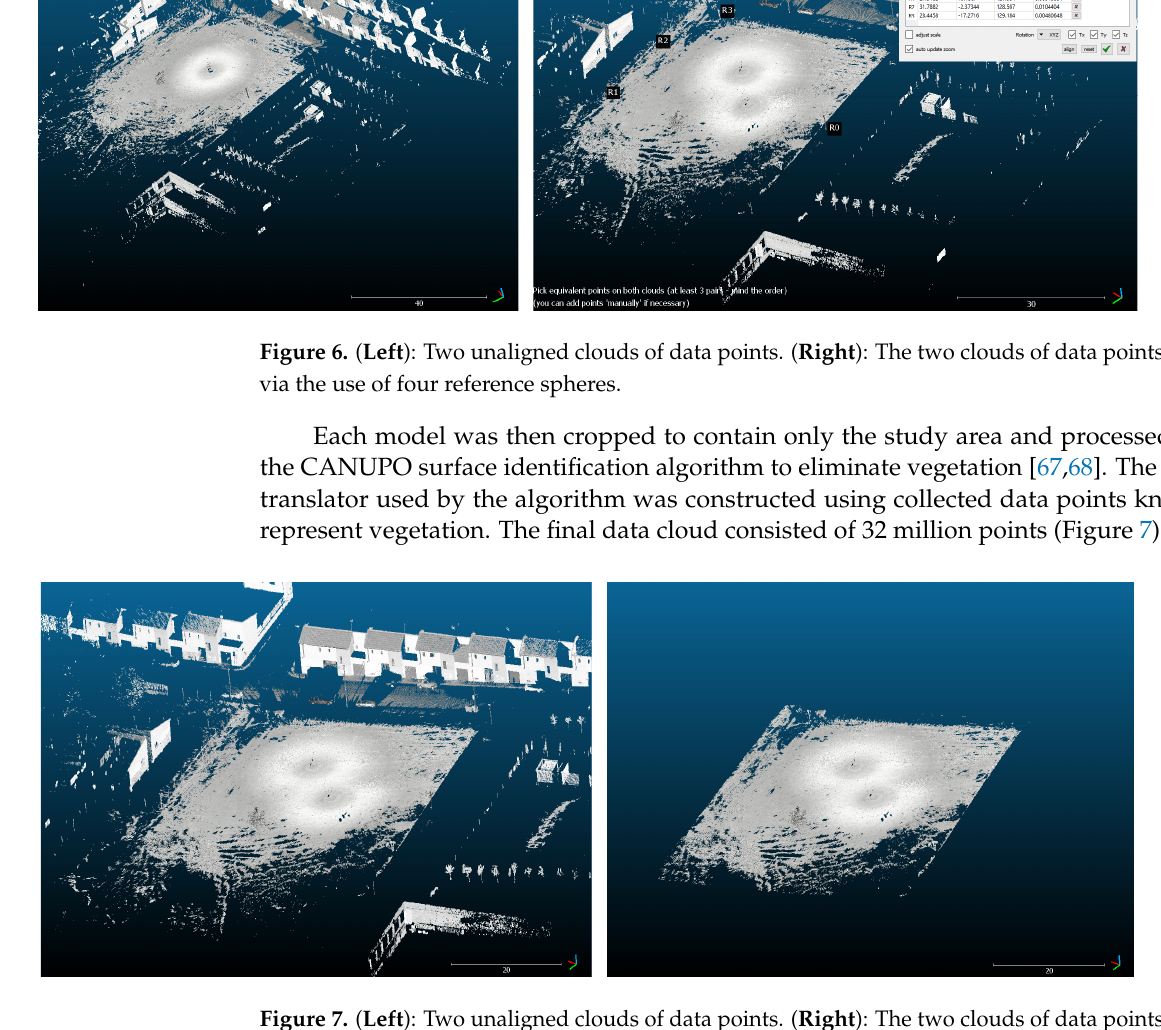
Figure 7. ( Left ): Two unaligned clouds of data points. ( Right ): The two clouds of data points aligned via the use of four reference